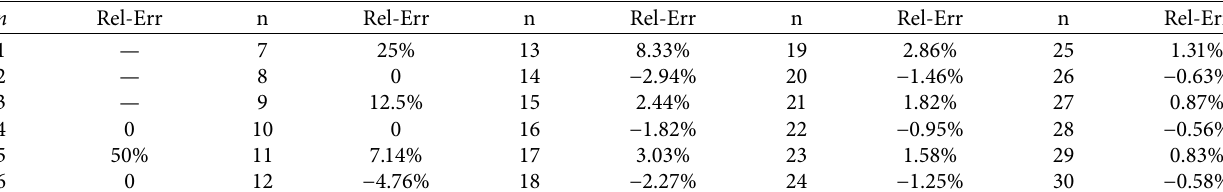
( n ) when 1000 ≤ n ≤ 10000, step ga ( n ) + 1/2 􏽪 􏽫 to h ( n ) when n ≤ 30. ga